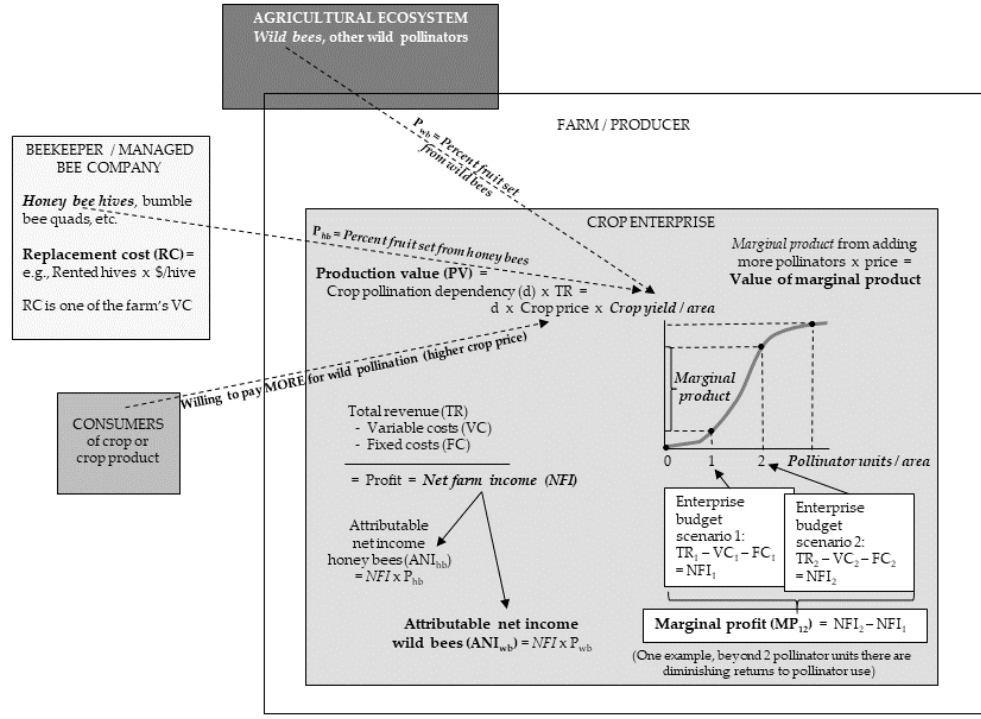
Figure 3. Flowchart diagramming relationships between wild bee pollination value metrics.